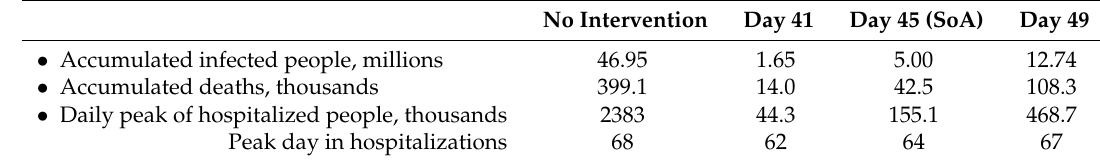
Table A1. Simulation results of the timing of social distancing in Spain.